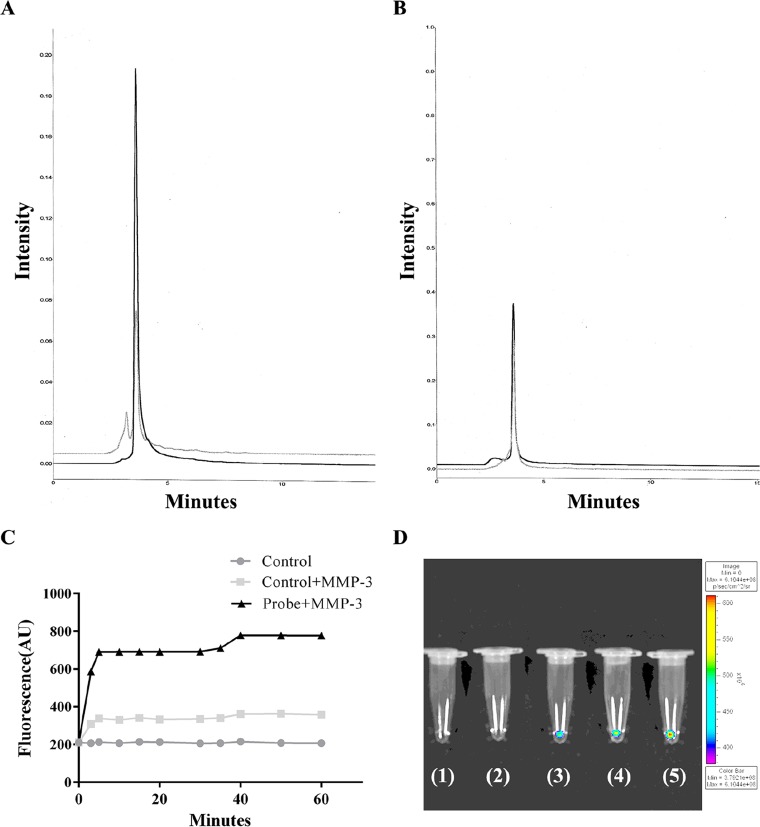
Characterization of the novel stromelysine-1 peptide substrate.HPLC chromatogram of the (A) stromelysine-1 peptide substrate (black) and their digested products by MMP-3(gray) as well as (B) the control peptide (black) and their digested products by MMP-3 (gray). (C) In vitro activation and inhibition of experimental and control NIRF probes; the probes (0.009 μM) were incubated with or without MMP-3 (1 unit) in 50 mM Tris buffer solution. (D) In vitro imaging of the MMP-3 NIRF probe activated by the MMP-3 enzyme. The manifest orange-yellow color was detected in the tubes containing the MMP-3 probe with activated MMP-3 (3–5) compared with the blank (1) and MMP-3 only (2) control tubes. A series of MMP-3 probes at 0.045 ng/μL (3), 0.09 ng/μL (4), and 0.18 ng/μL (5) with MMP-3 (0.1 ng/μL) resulted in increasing SIs of 3.85 ± 0.15, 4.51 ± 0.12, and 4.86 ± 0.17 respectively. Six samples in triplicate were measured. Optical imaging was performed at 610–650nm excitation and 670–700nm emission. HPLC, high-performance liquid chromatography; MMP, matrix metalloproteinase; NIRF, near-infrared fluorescence.